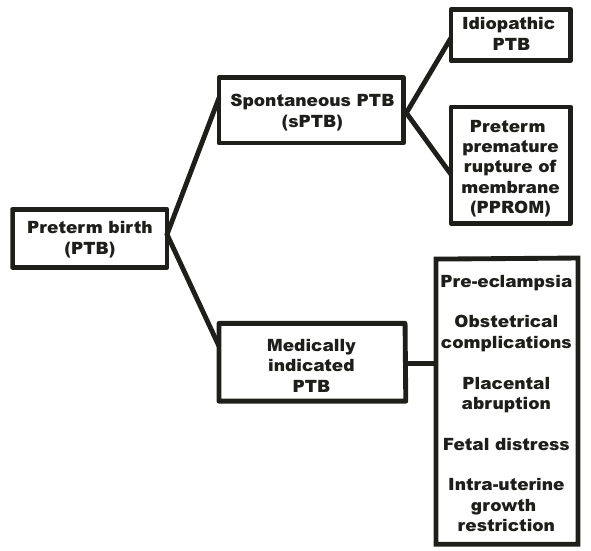
Fig. 1 Schematic representation of the categories of preterm birth. Spontaneous PTB and medically indicated PTB are two subtypes of preterm birth (PTB). Spontaneous PTB can be further subdivided into idiopathic PTB and preterm premature rupture of membrane (PPROM). In idiopathic PTB, uterine contractions and cervical dilation is followed by rupture of the fetal membrane before the expulsion of the baby out of the womb while in PPROM, the fetal membranes get ruptured before the initiation of uterine contractions before 37 weeks of gestational age. Medically indicated PTB can be further classi fi ed into pre-eclampsia, obstetrical complications, placental abruption, fetal distress, and intrauterine growth restriction.